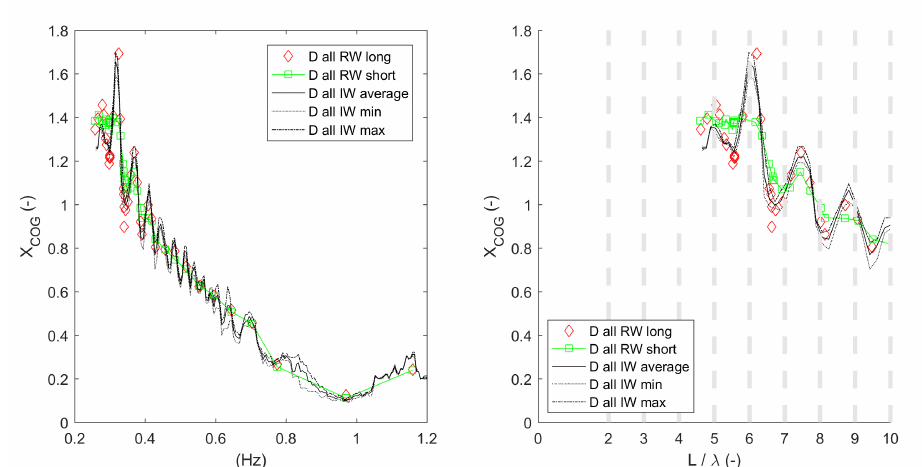
Figure 21. Surge RAOs from regular and irregular waves in basin D (as function of frequency ( left ) and ratio of basin’s length by wave length ( right ).